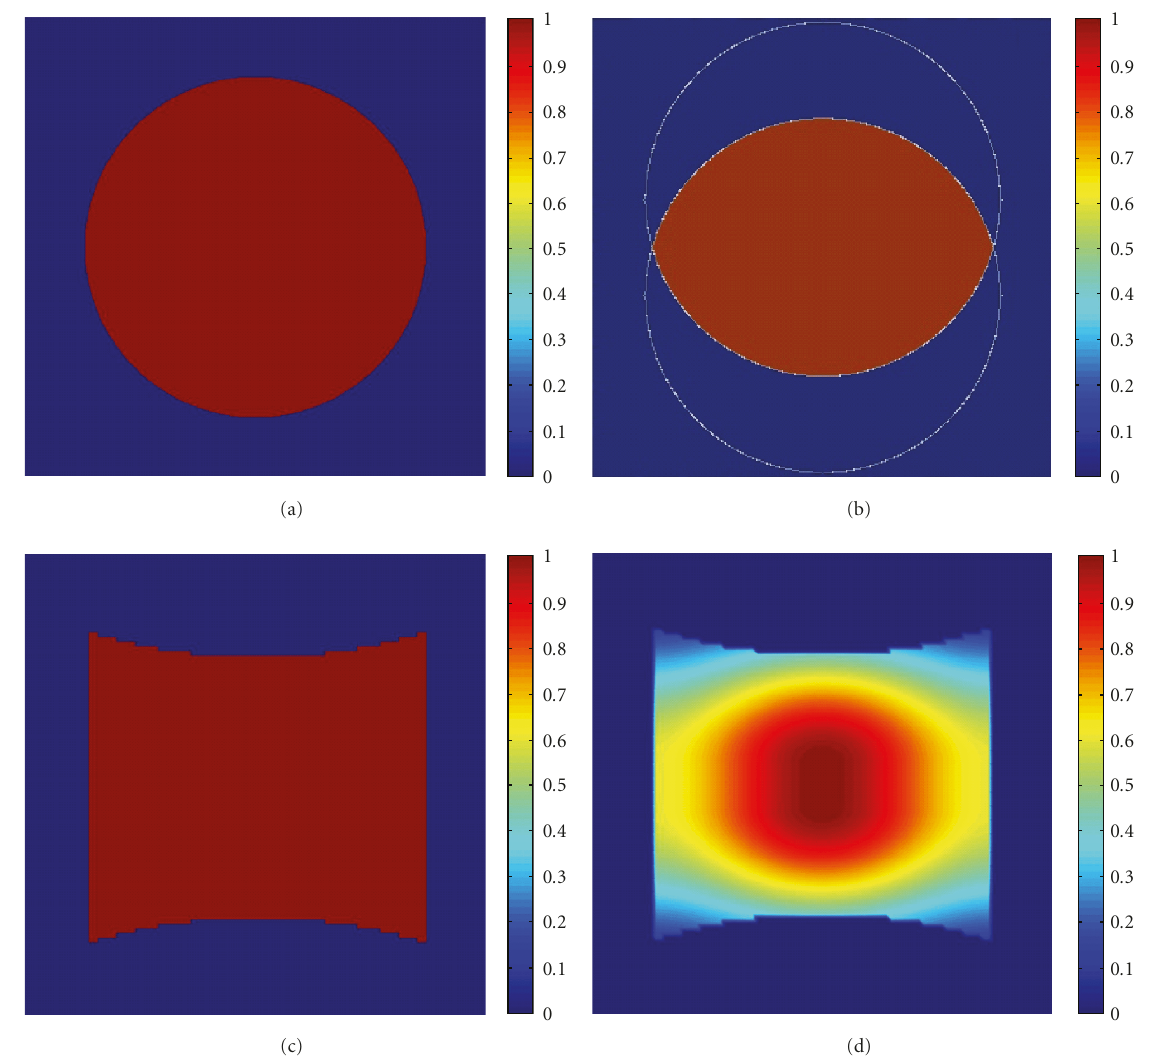
Figure 5: Di ff erent forms that can be used to shape the migration operator aperture in order to resemble the real radar footprint; (a) and (b) are applicable to the one-step 3D operator to simulate a monostatic and a bistatic footprint, respectively; (c) is the aperture of the two- step operator obtained with a trivial 2D aperture limitation applied to both the x and y -direction steps; (d) is the aperture of the two-step operator that can be obtained with a smooth weighting approach to resemble a shape similar to